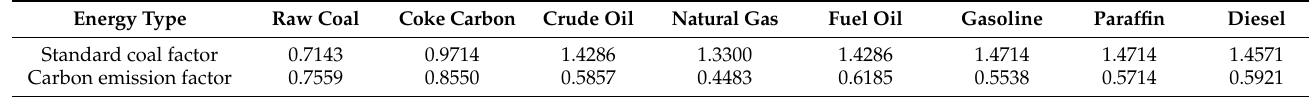
Table 1. Energy standard coal conversion factor and carbon emission